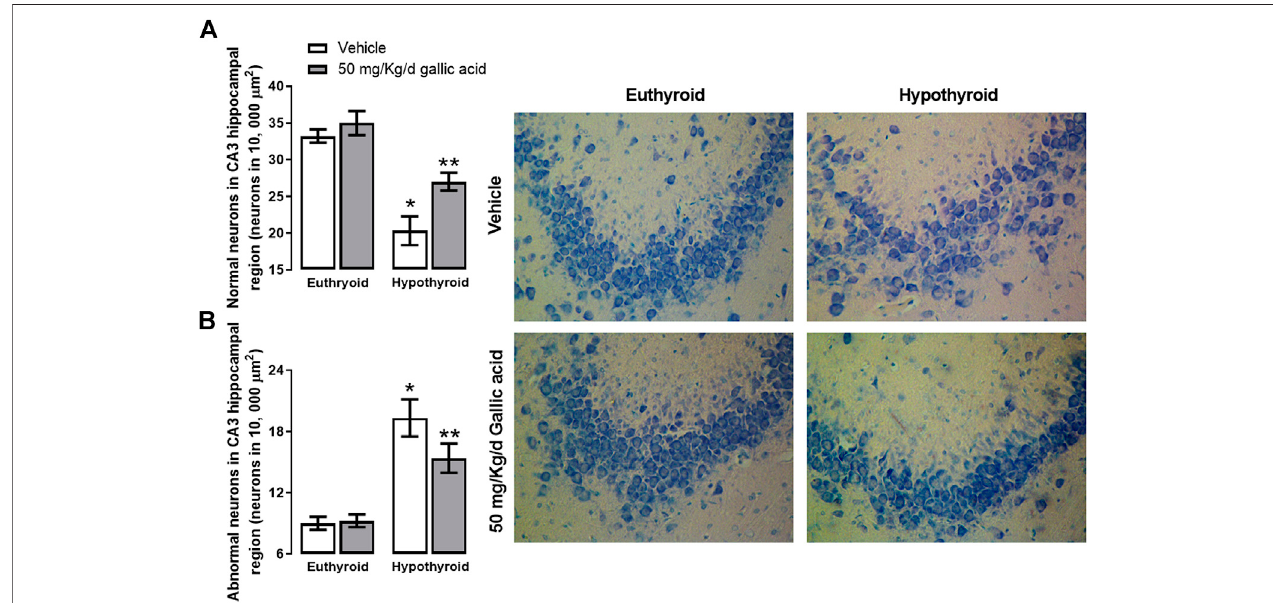
FIGURE 5 | Effect of gallic acid on hypothyroidism-induced morphological alteration in CA3 hippocampal region of adult rats. It shows normal (A) and abnormal neurons (B) . In the fi gure ’ s right, there are representative photomicrographs of the treated groups stained with toluidine blue. Values represent the mean ± SEM. (*) p < 0.05 vs. Euthyroid + vehicle group. (**) p < 0.05 vs. hypothyroid + vehicle